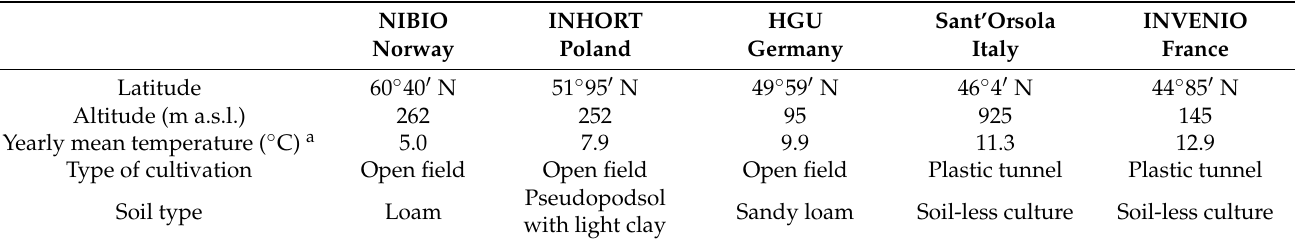
Table 1. Geographic latitude and altitude, yearly mean temperature, cultivation conditions, and soil type for the five experimental locations in